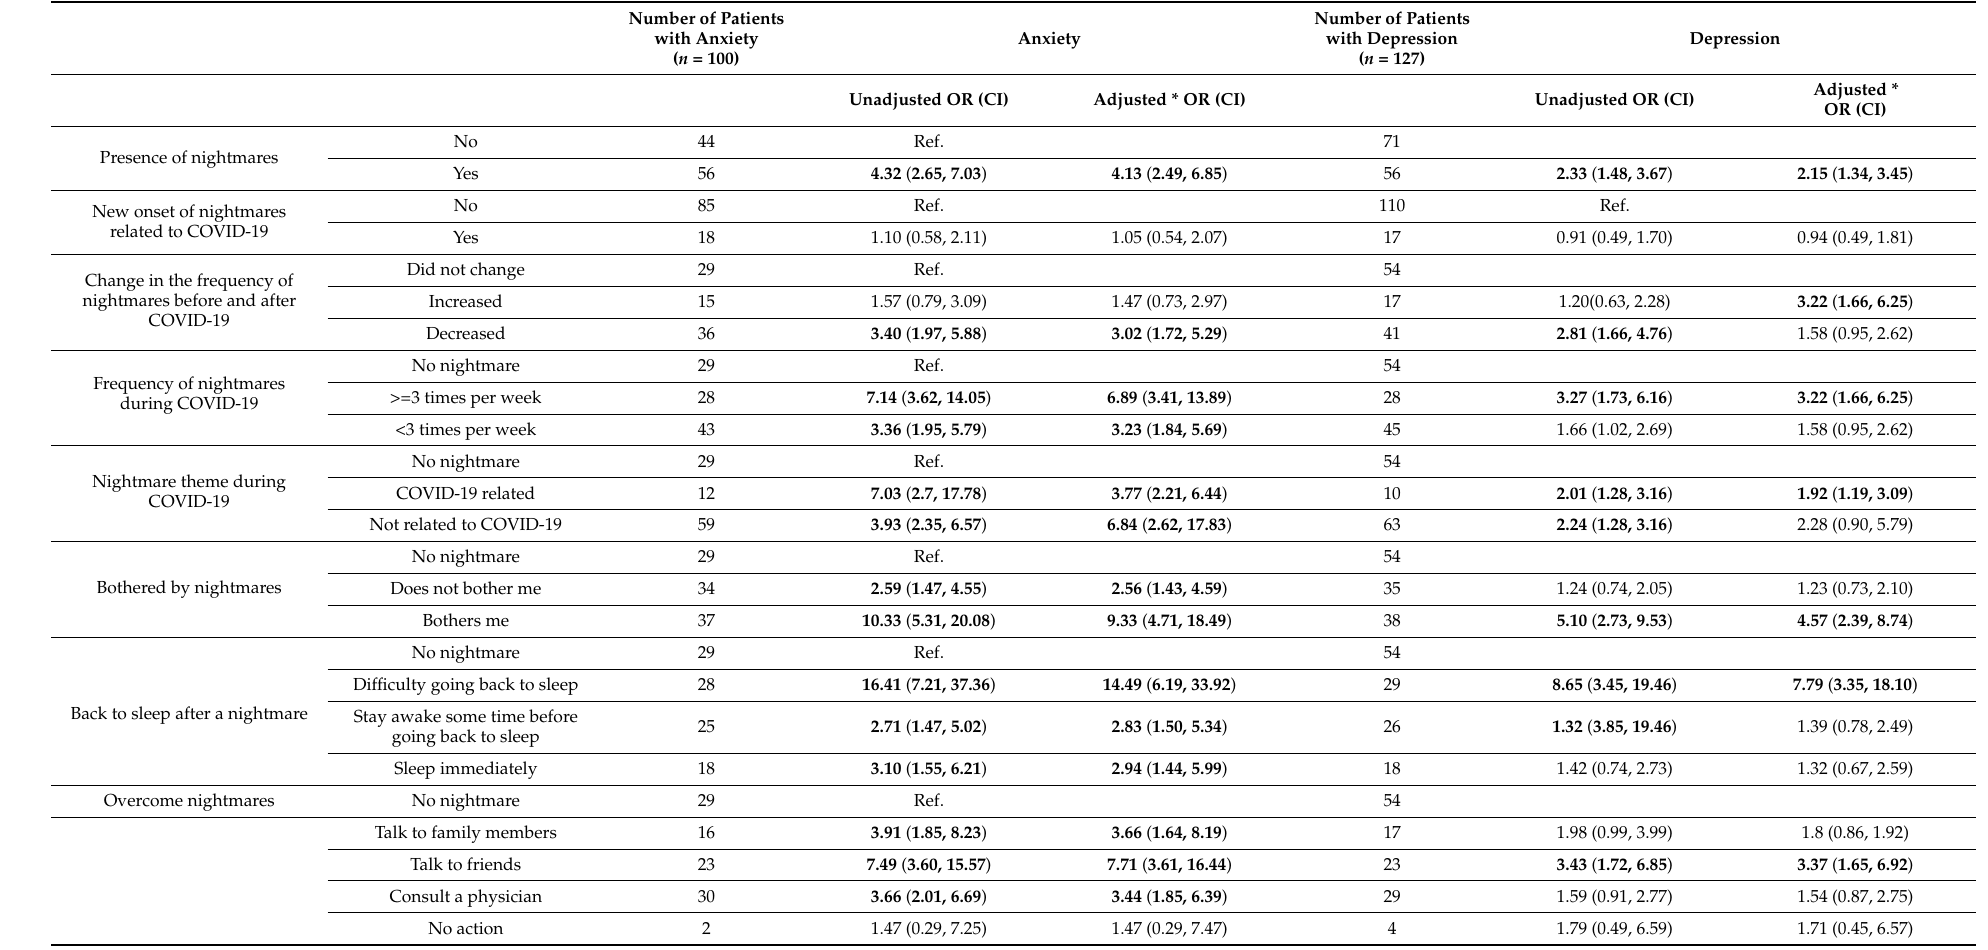
Table 4. Results of several adjusted and unadujsted logistic regression models that estimated the risk of having anxiety and depression in relation to several nightmare indicators. Number of Patients Number of Patients with Anxiety Anxiety with Depression Depression ( n = 100) ( n = 127) Unadjusted OR (CI) Adjusted * OR (CI) Unadjusted OR (CI) Adjusted * OR